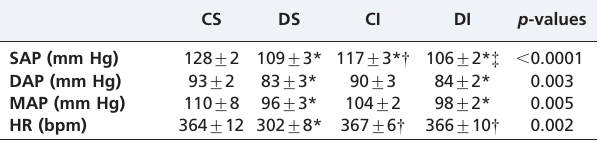
Values are expressed as the means ¡ SEM. SAP – Systolic arterial pressure; DAP – Diastolic arterial pressure; MAP – Mean arterial pressure; HR – Heart rate. * p , 0.05 vs. CS;